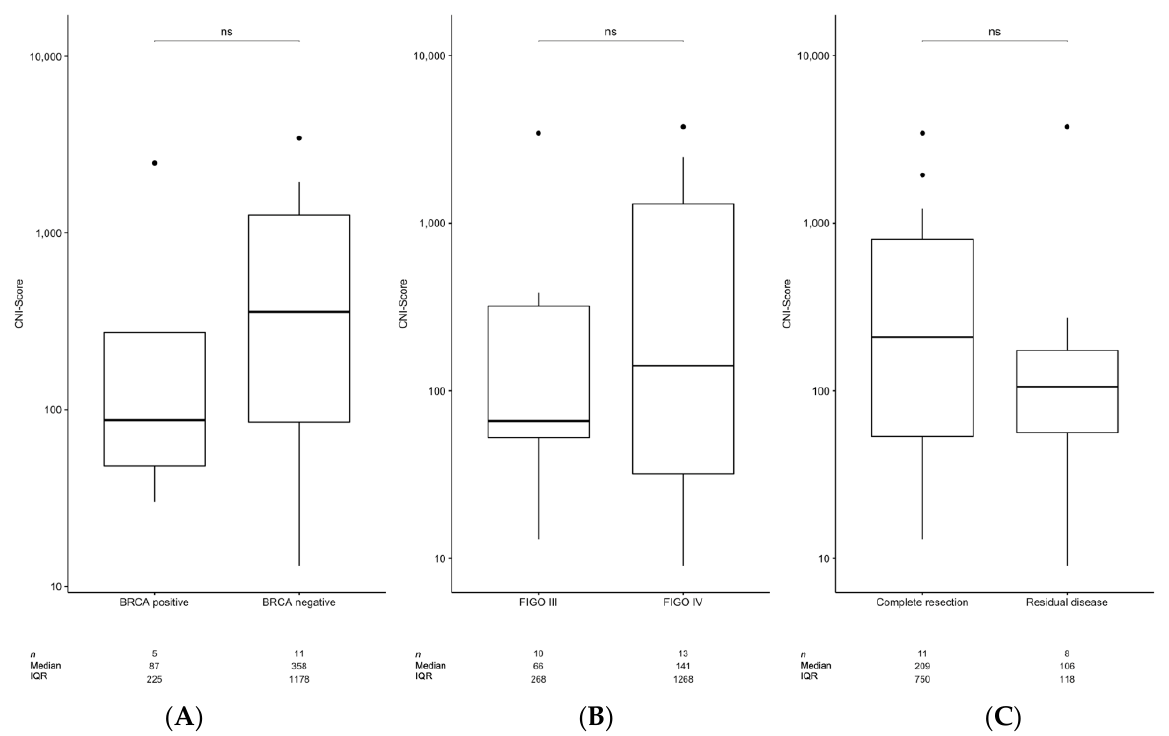
Figure 2. Comparison of the CNI-Scores between ( A ) different FIGO states and ( B ) BRCA -mutation-status-only samples from patients from the upfront group were included. ( C ) CNI-Score differences between patients with and without com- plete resection. The centerlines show the medians; box limits indicate the 25th and 75th percentiles, as determined using between patients with and without complete resection. The centerlines show the medians; box a non-parametric Wilcoxon test (R); whiskers extend 1.5 times the interquartile range from the 25th and 75th percentiles; limits indicate the 25th and 75th percentiles, as determined using a non-parametric Wilcoxon test and outliers are represented by dots. The number of sample points per group, median, and interquartile range (IQR) are given as tables. A non-parametric Wilcoxon test was performed to test for statistical differences between the groups (ns: p > 0.05).